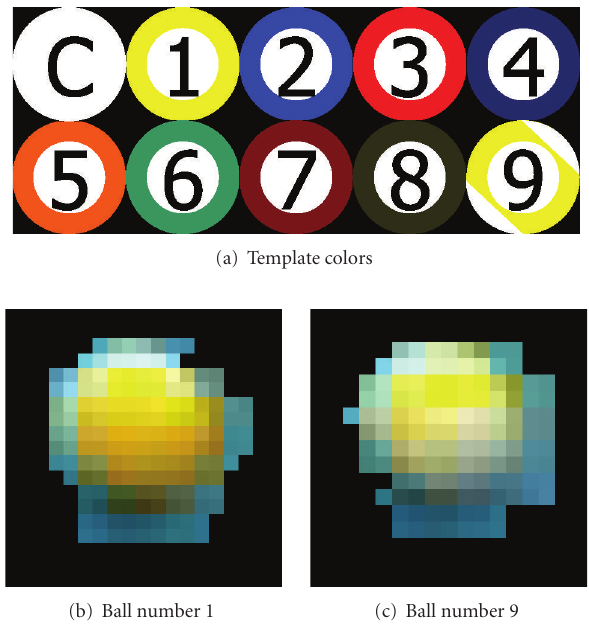
Figure 8: Correction by user